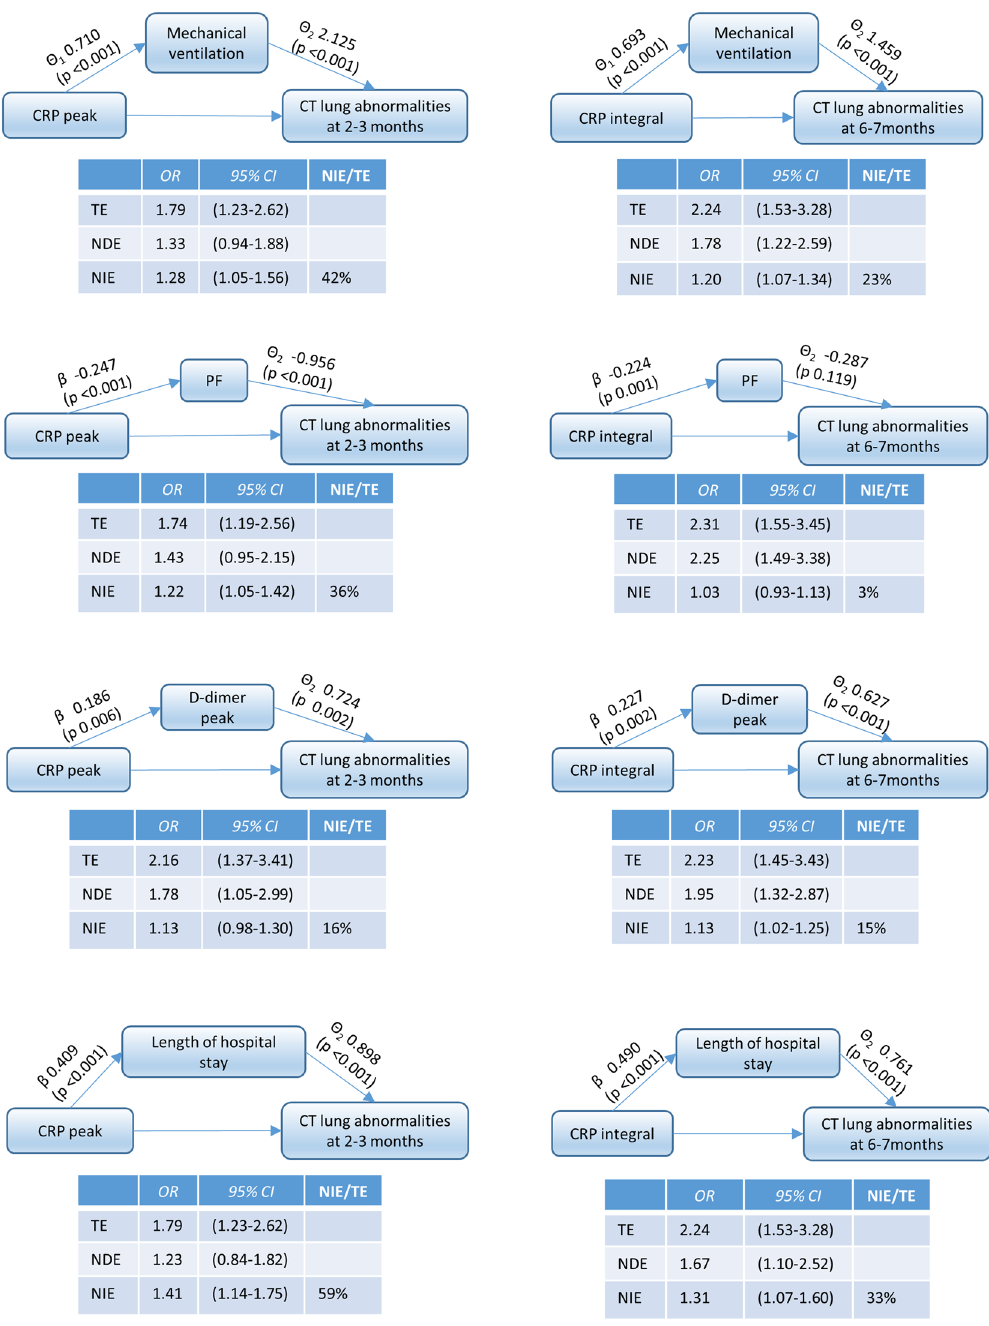
Figure 6. Path diagrams representing the mediation effect of mechanical ventilation, lowest PaO2/FiO2, D-dimer peak, and length of hospital stay in the relationship between CRP peak and CT lung abnormalities at 2–3 months and between CRP integral and CT lung abnormalities at 6–7 months. θ1 is the estimated effect (Ln OR) of CRP descriptors on mechanical ventilation adjusting for confounders. θ2 is the estimated effect (Ln OR) of mediators on persistent lung abnormalities adjusting for confounders. β is the correlation coefficient of CRP descriptors on mediators. Confounders include age and sex. In the tables we report the decomposition of the effect of CRP descriptors on persistent lung abnormalities. OR, odds ratio; TE, total effect; NDE, natural direct effect; NIE, natural indirect effect; NIE/TE, % mediation